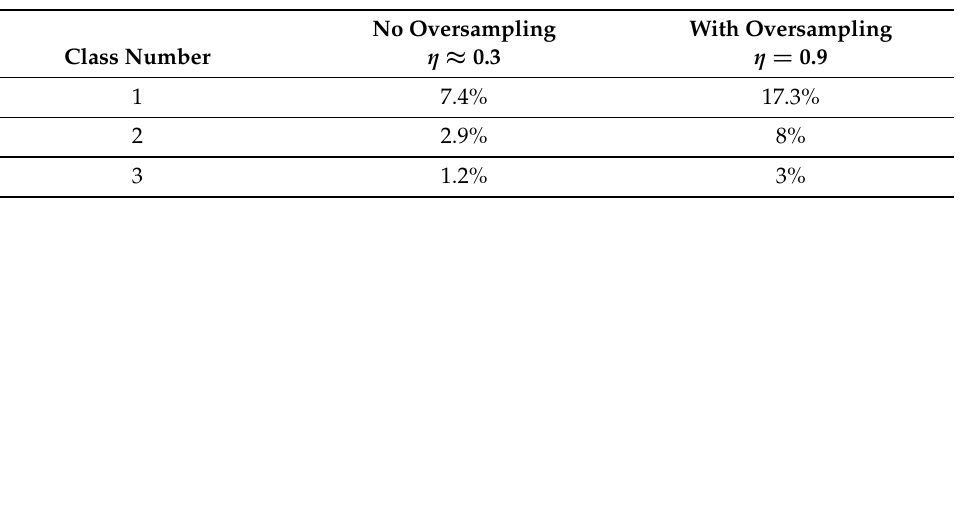
Table 4. Comparison of the proportion of pixels in each class before and after